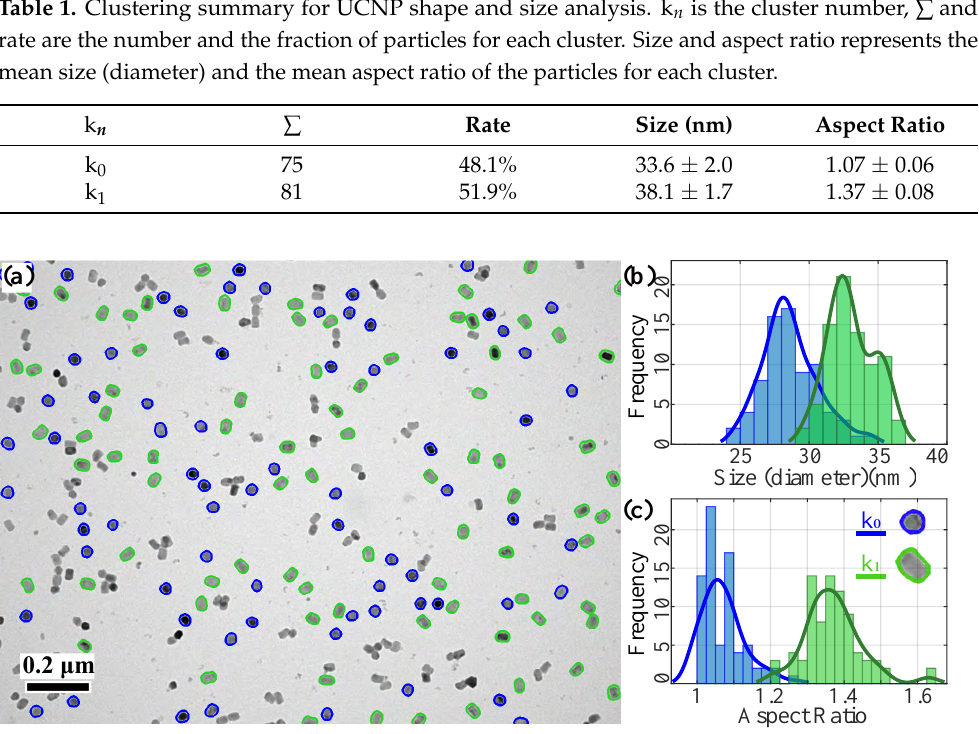
Figure 4. Shape classification results for the TEM image of UCNPs. ( a ) The two different shape classification particle contours are marked with two colors. ( b ) Size distribution (approximate diameter assuming the particles are spherical) of the two clusters, k 0 and k 1 . ( c ) Aspect ratio distribution of the two